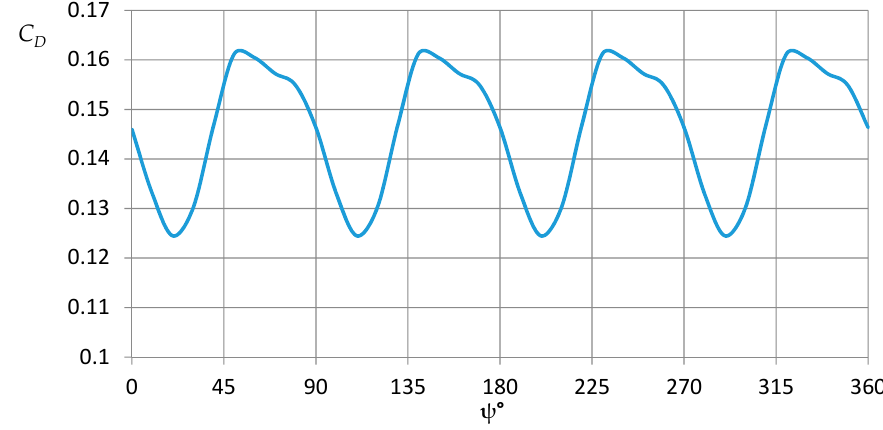
Figure 8. Fuselage drag as function of the blade azimuth.